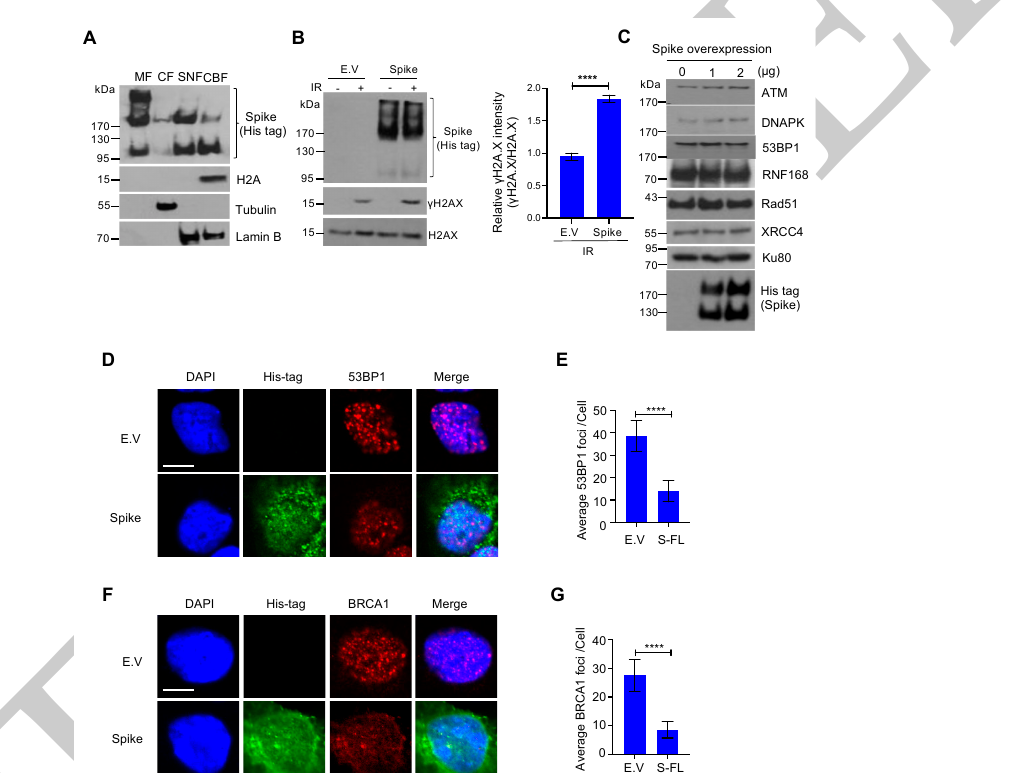
Figure 3. Severe acute respiratory syndrome coronavirus 2 (SARS–CoV–2) spike protein impedes the recruitment of DNA damage repair checkpoint proteins. ( A ) Membrane fraction (MF), cytosolic fraction (CF), soluble nuclear fraction (SNF), and chromatin-bound fraction (CBF) from HEK293T cells transfected with SARS–CoV–2 spike protein were immunoblotted for His-tag spike and indicated proteins. ( B ) Left: Immunoblots of DNA damage marker γ H2AX in empty vector (E.V)– and spike protein–expressing HEK293T cells after 10 Gy γ -irradiation. Right: corresponding quantification of immunoblots in left. The values represent the mean ± SD ( n = 3). Statistical significance was determined using Student’s t –test. **** p < 0.0001. ( C ) Immunoblots of DNA damage repair related proteins in spike protein–expressing HEK293T cells. ( D ) Representative images of 53BP1 foci formation in E.V– and spike protein-expressing HEK293 cells exposed to 10 Gy γ –irradiation. Scale bar: 10 µ m. ( E ) Quantitative analysis of 53BP1 foci per nucleus. The values represent the mean ± SEM, n = 50. ( F ) BRCA1 foci formation in empty vector- and spike protein-expressing HEK293 cells exposed to 10 Gy γ –irradiation. Scale bar: 10 µ m. ( G ). Quantitative analysis of BRCA1 foci per nucleus. The values represent the mean ± SEM, n = 50. Statistical significance was determined using Student’s t -test. **** p <